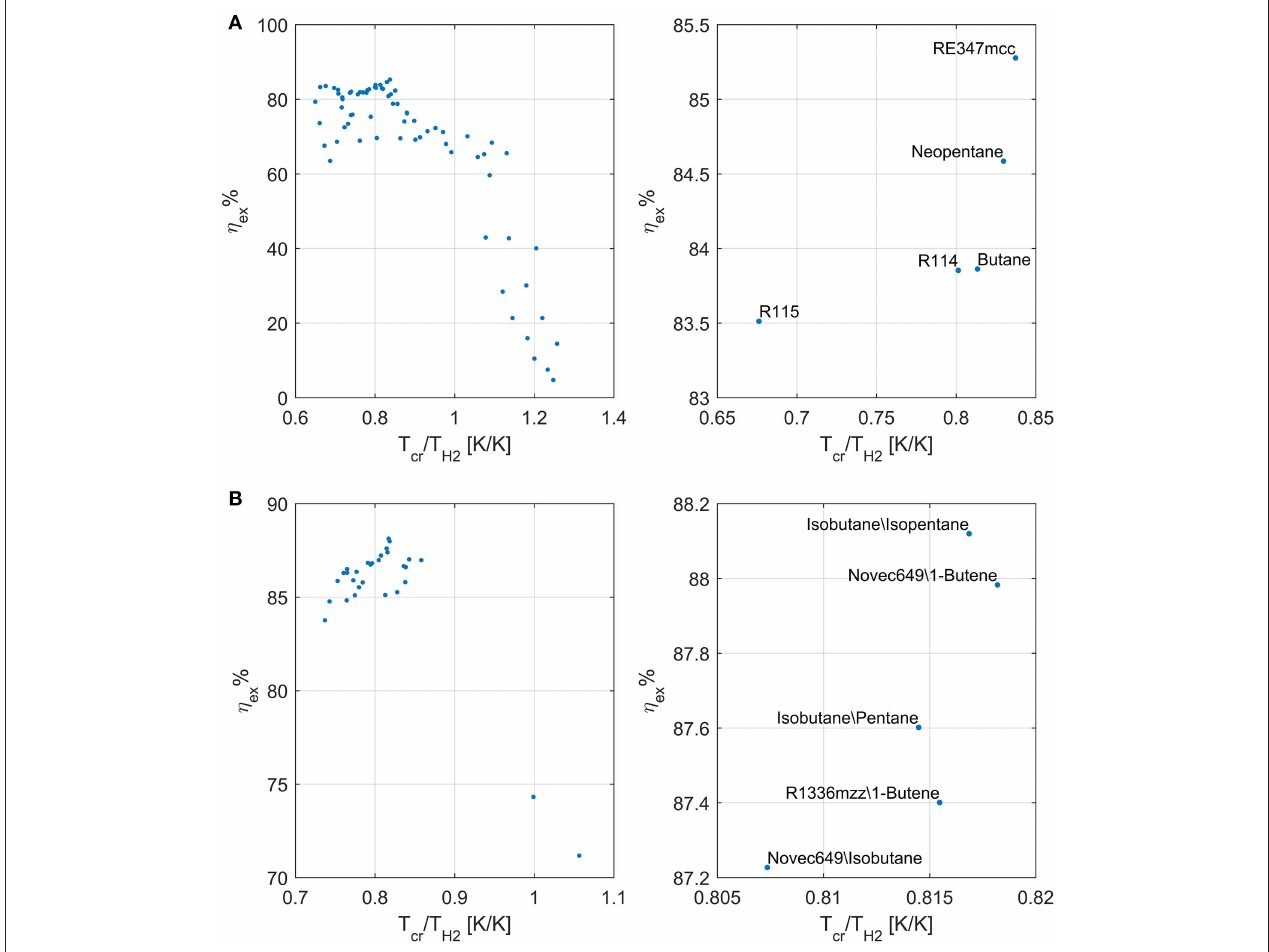
FIGURE 3 | Exergy efficiency of the considered pure fluids (A) and mixtures (B) as a function of the ratio between their critical temperature and the inlet temperature of the hottest